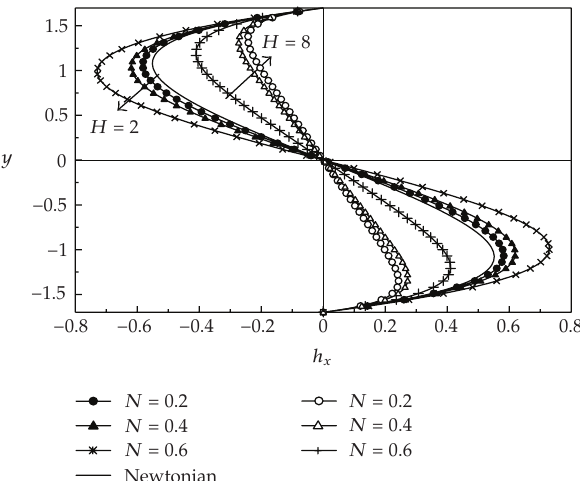
Figure 8: Variation of the axial-induced magnetic field across the channel for α (cid:8) 0 . 4 , θ (cid:8) 1 . 2 , m (cid:8) 2 , R m (cid:8) 1, and di ff erent values of N and H